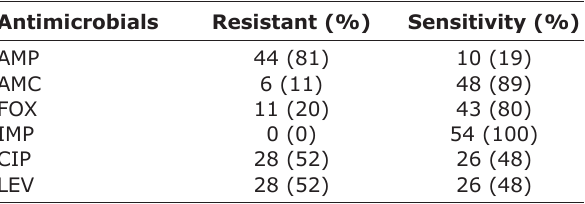
Figure-1: Distribution of diarrheagenic Escherichia coli pathotypes. Table-1: Antibiogram of diarrheagenic Escherichia coli isolates